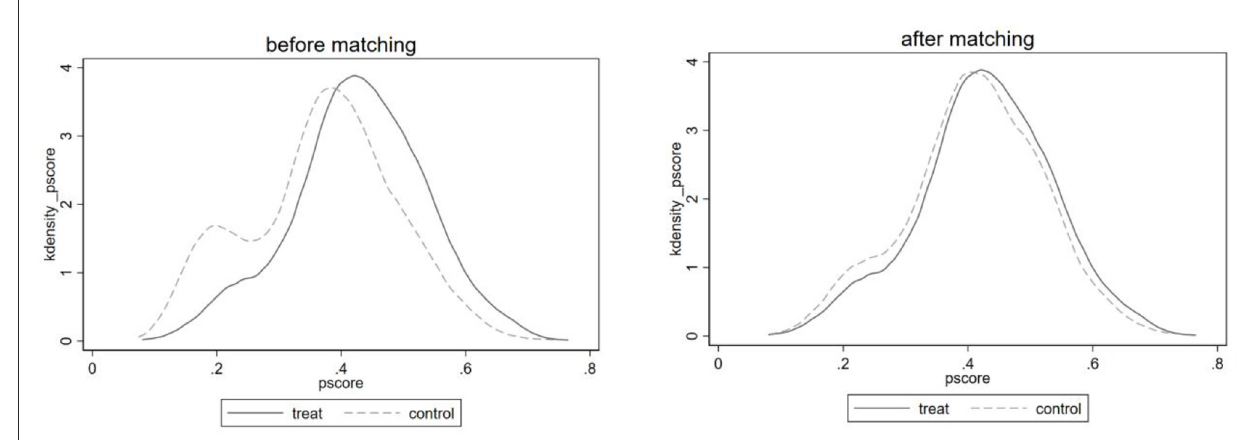
FIGURE2 Nuclear density distribution of propensity scores of treatment group and control group before and after